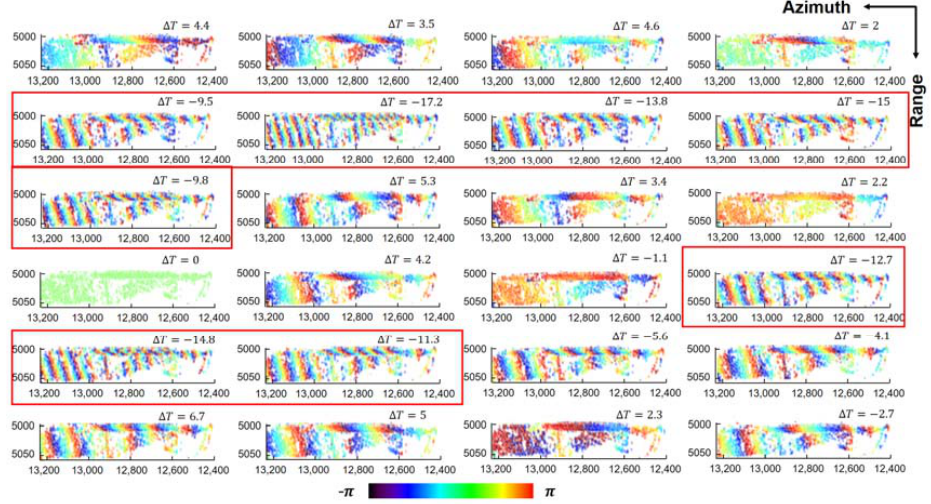
Figure 4. The time series differential interferograms of the SWFC, the red rectangles indicate the differential interferograms with larger temperature differences and denser fringes.